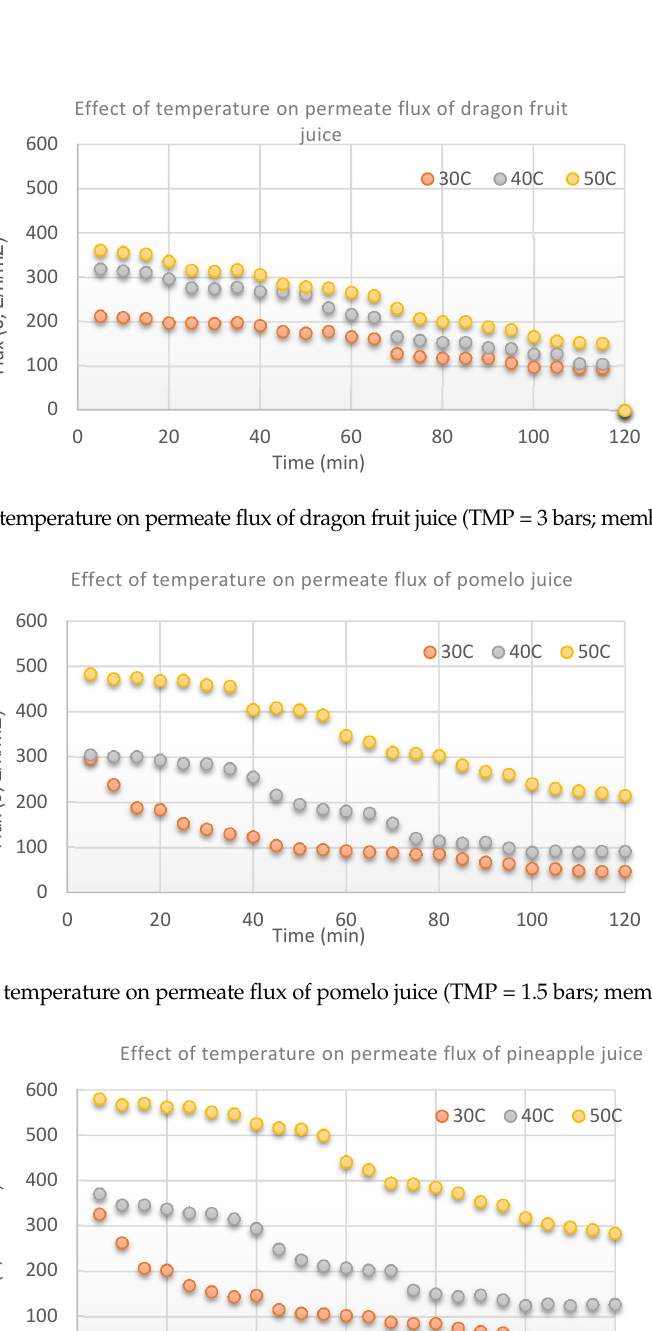
Figure 10. Effect of temperature on permeate flux of cashew apple juice (TMP= 1.5 bars; membrane = 500 nm).